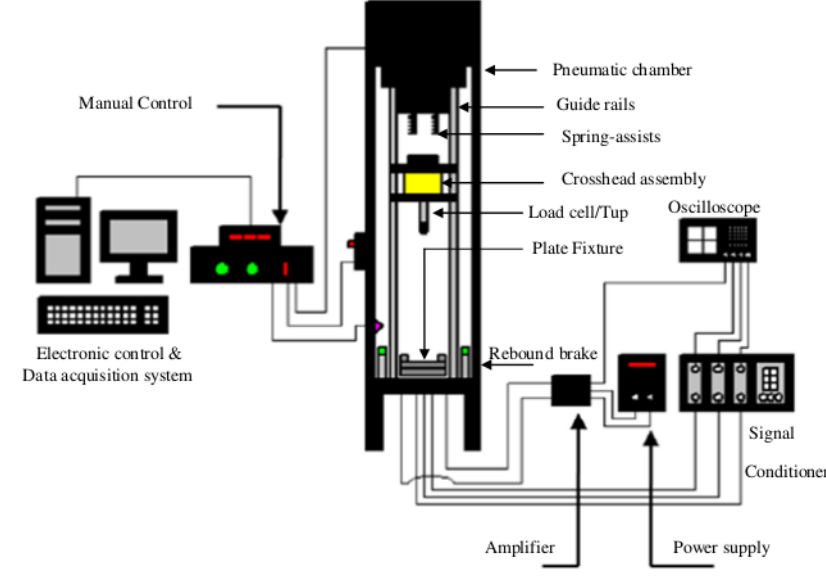
Figure 3: Schematic of SCHINSTRON TM 9250HV impact test